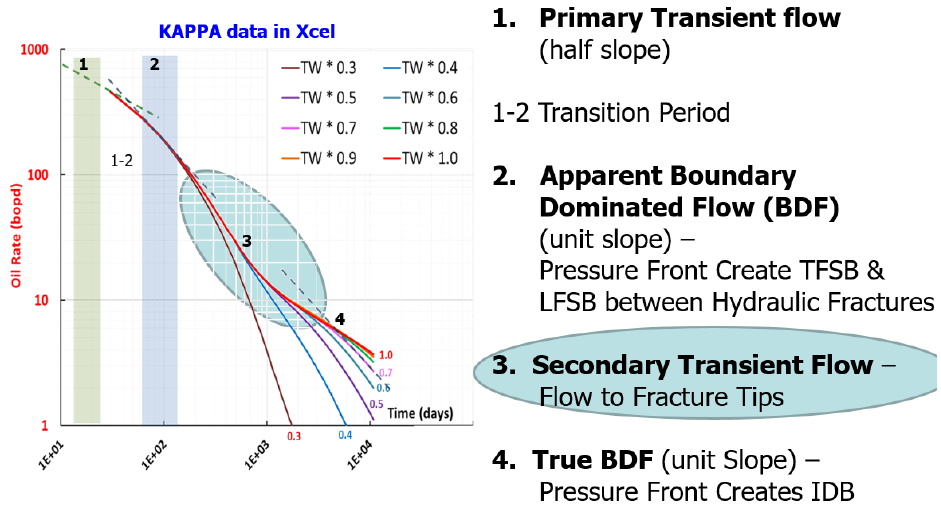
Figure 15. Log-log rate versus time plots for various well spacing with W/TW ranging between 1.0 to 0.3. After [7].